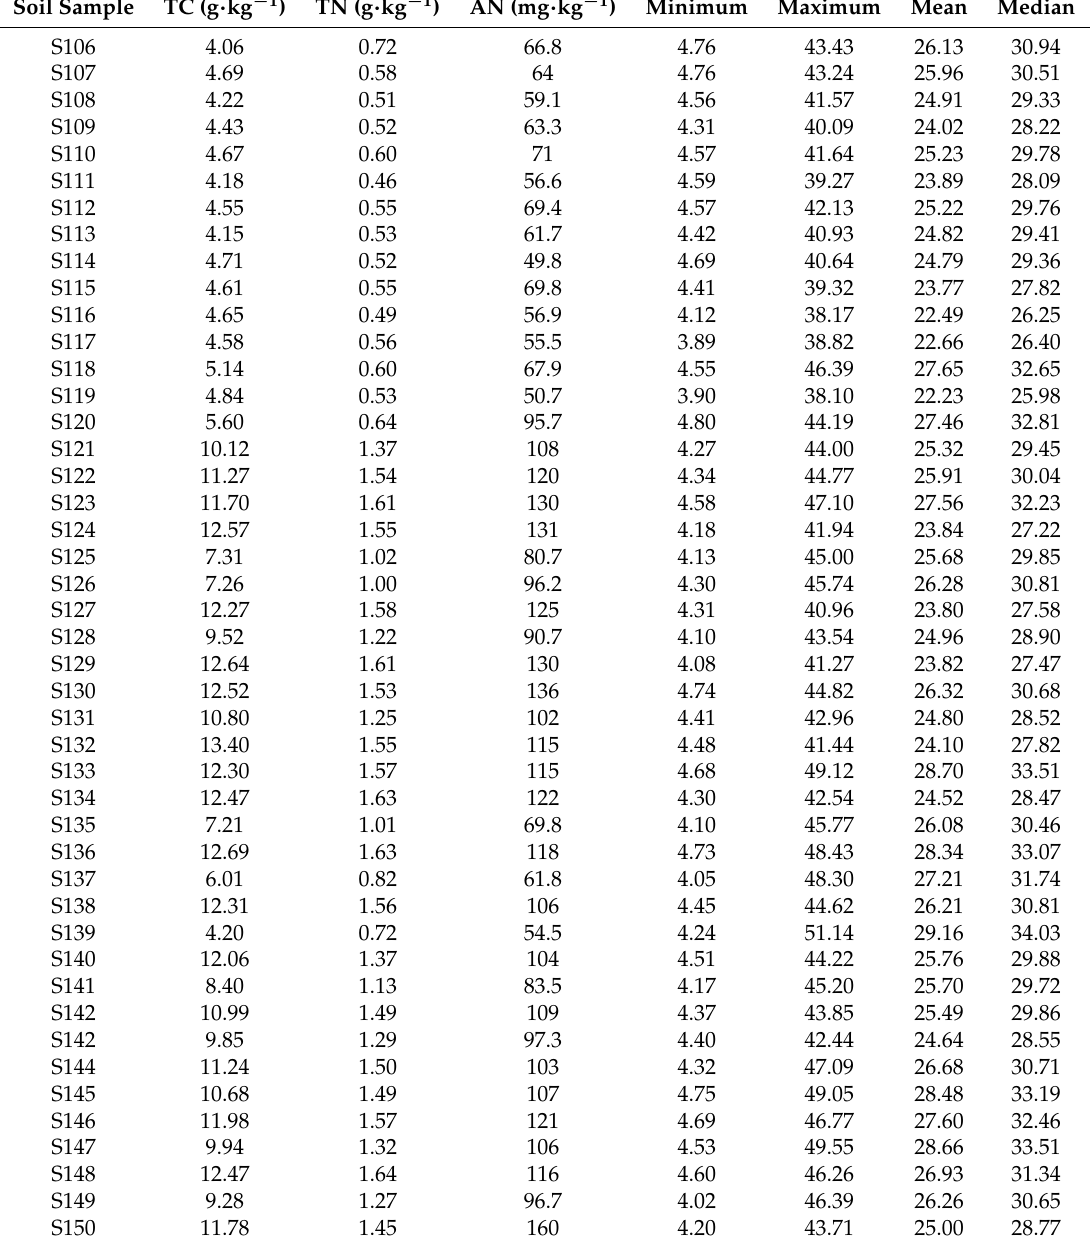
Table A3. Basic information on samples from S106 to